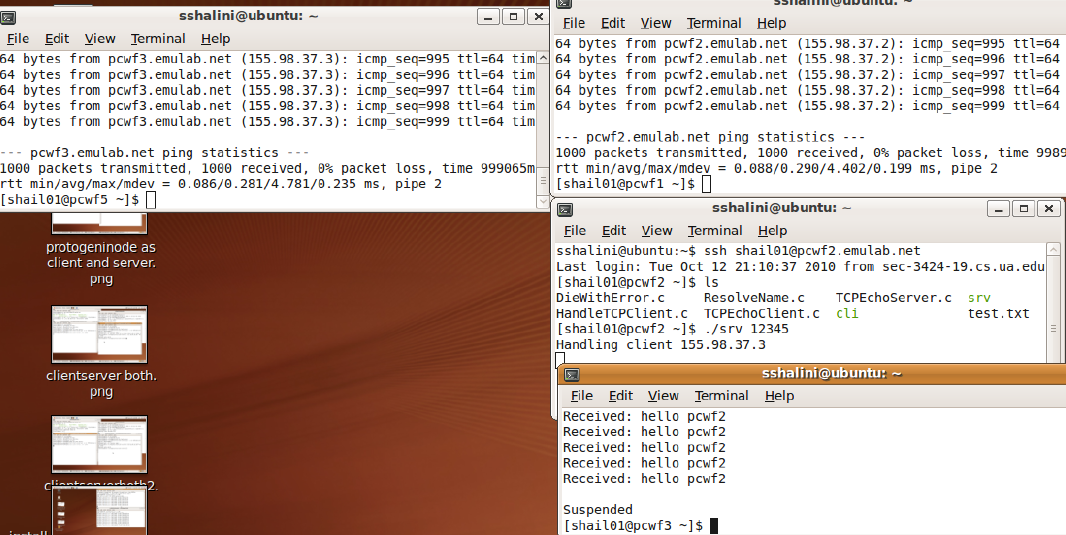
Fig. 18: Cross communication between two experiments with wireless